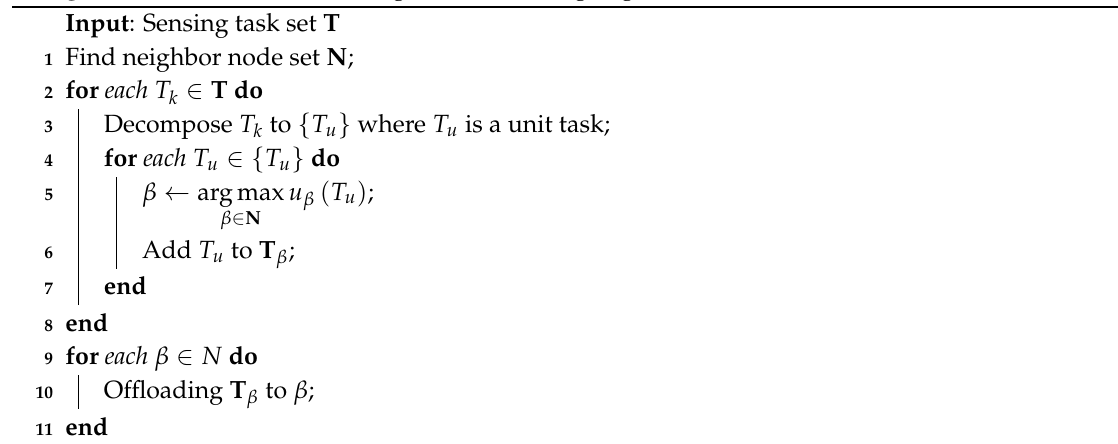
Algorithm 1: Distributed Sensing Task Offloading